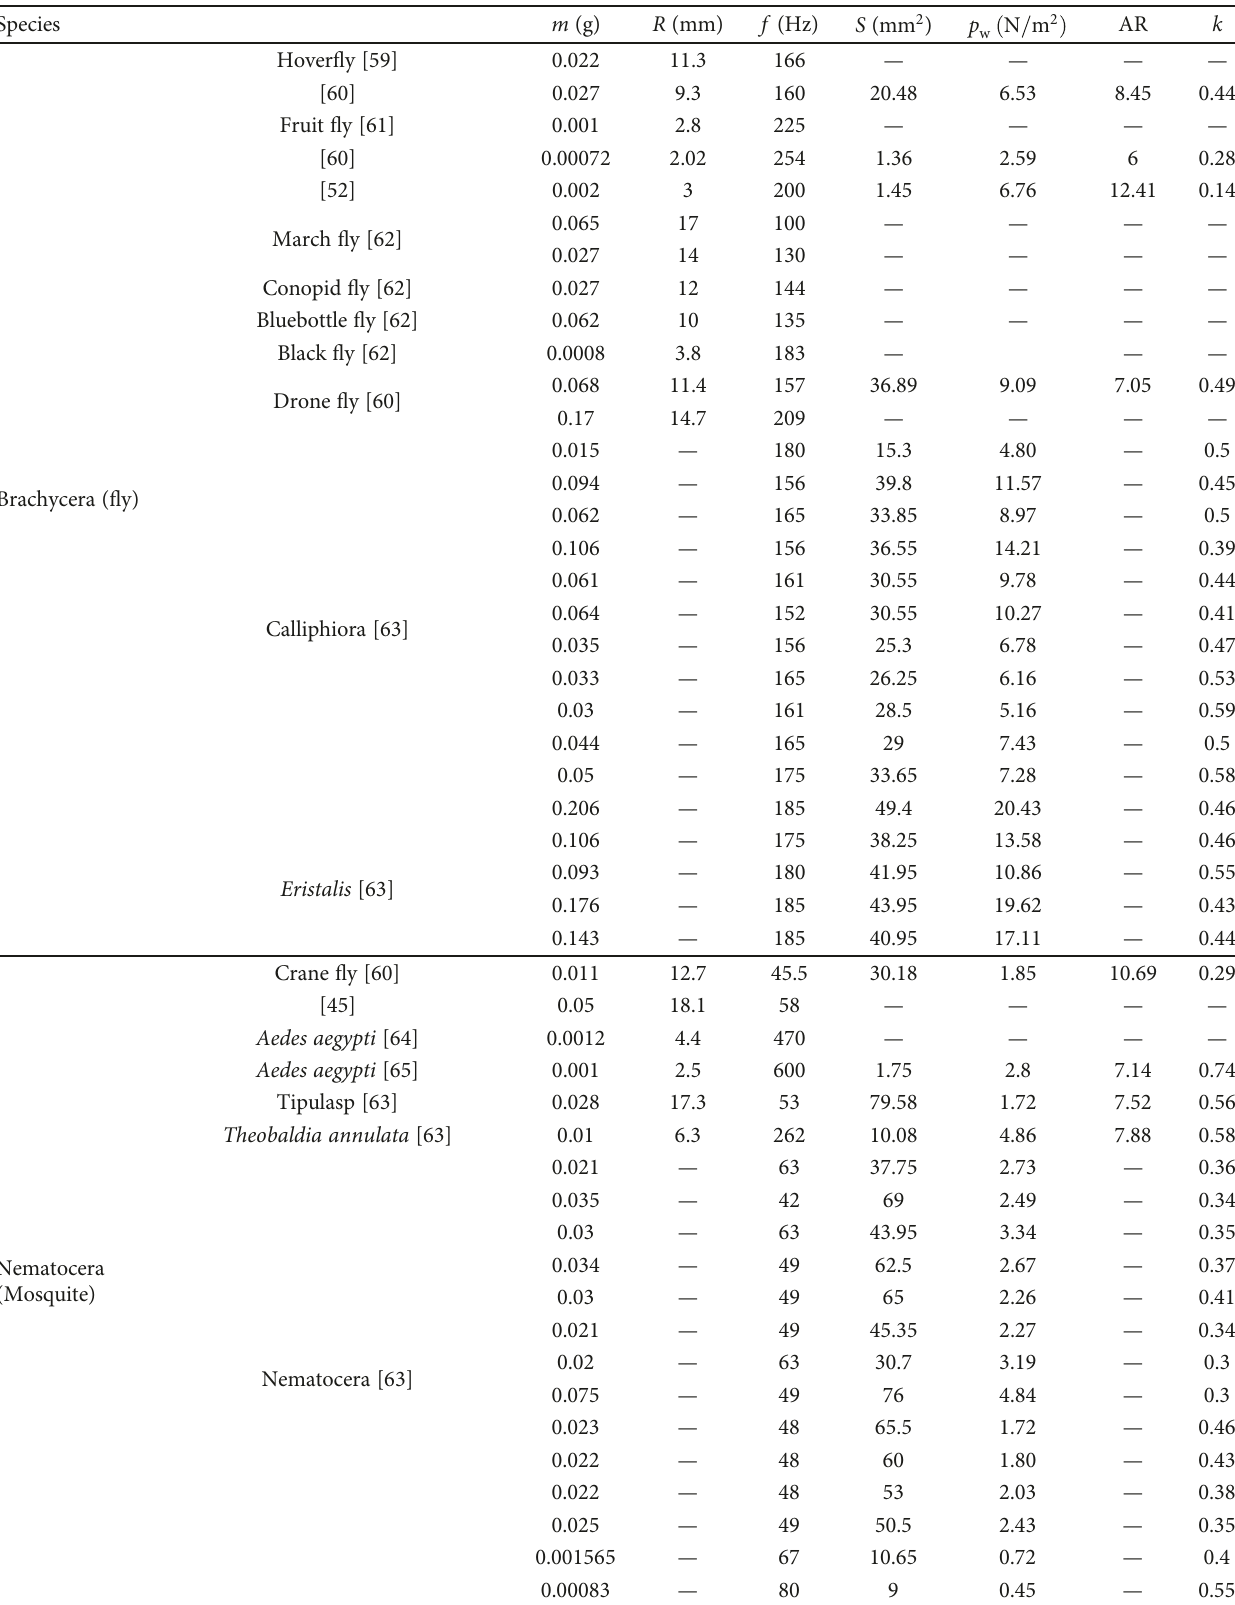
Table 1: Wing parameters of various natural fl yers.